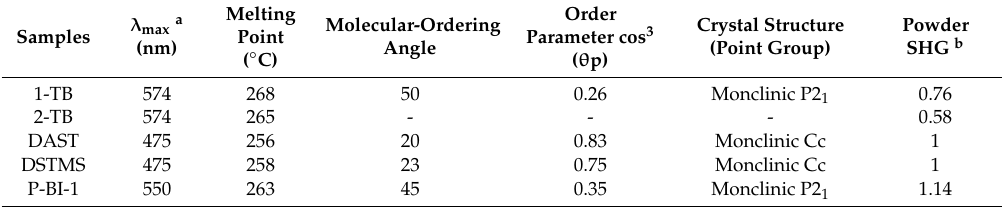
Table 1. Table 1. Physical properties of investigated compounds.